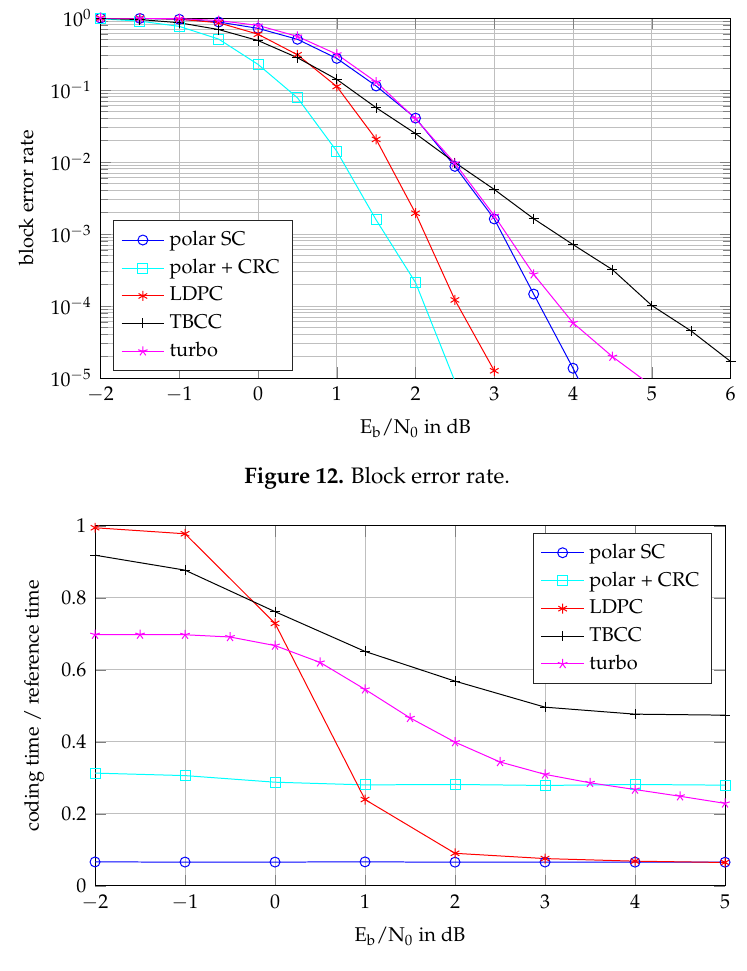
Figure 13. Average decoding time normalized to the reference